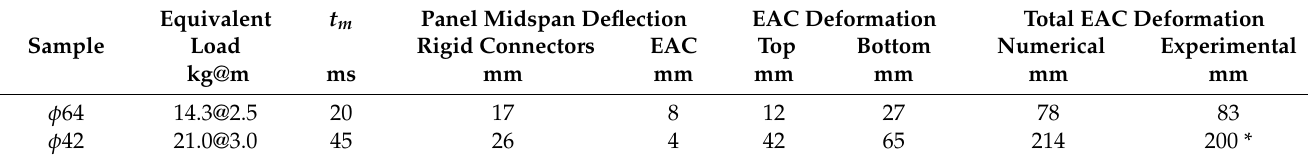
Table 7. Validation of the FE